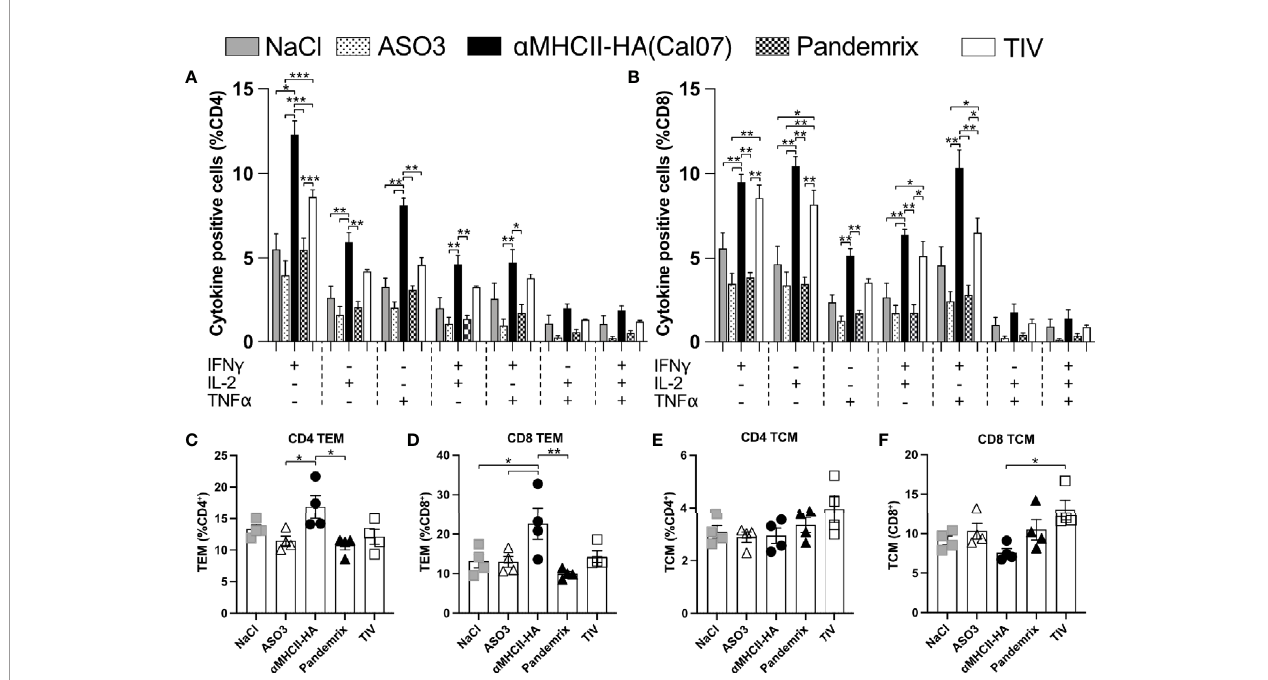
FIGURE 6 | Multifunctional T cell subsets after vaccination. Mice (n=4/group) were vaccinated once i.m. with the indicated vaccines. 21 days after vaccination, splenocytes were harvested, and following overnight resting stimulated for 4h with HA (Cal07) in the presence of a protein transport inhibitor. Single, double, or triple expression of cytokines IFN g , IL-2, and TNF a were investigated for CD4 (A) and CD8 (B) T cell subsets. (C, D) Effector memory (T EM ) and central memory (T CM ) T cell subsets were de fi ned as CD44 + CD64L - , and CD44 + CD64L + , respectively. (C) Presence of CD4 T EM . (D) Presence of CD8 T EM . (E) Presence of CD4 T CM . (F) Presence of CD8 T CM . Data shown are mean ± SEM, *P < 0.05, **P < 0.01, ***P < 0.001 (Anova og Tukey ’ s multiple